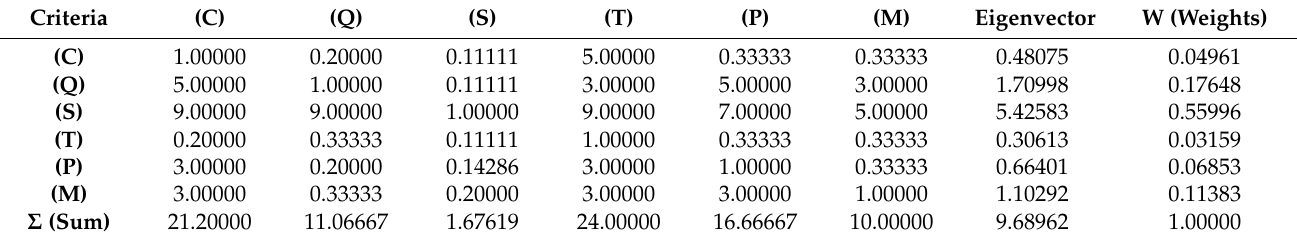
Table 8. Judgment matrix (full packaging engineer A).